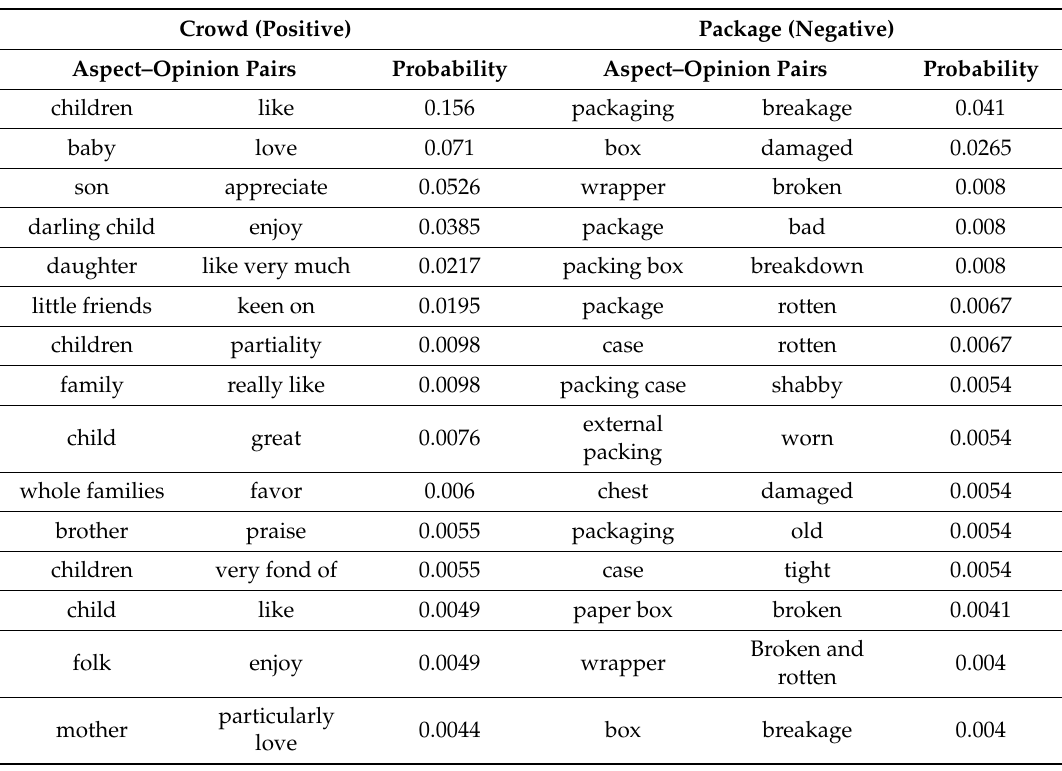
Table 4. Top 15 word pairs with probability of positive emotion of topic ‘Crowd’ and negative emotion of topic